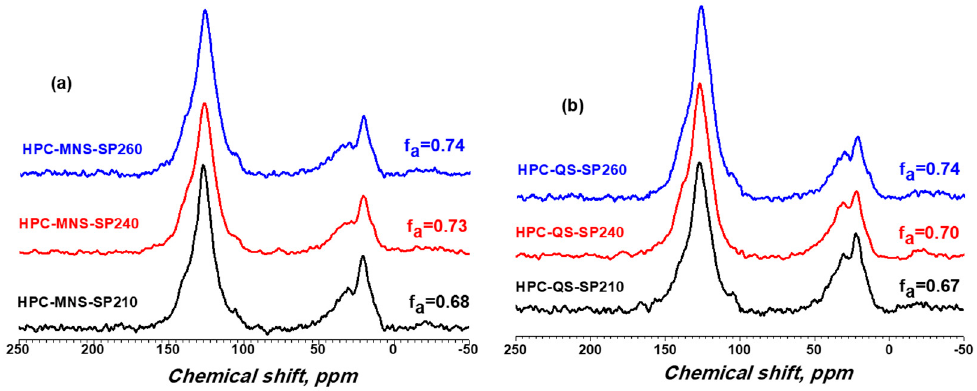
Figure 5. 13 C-NMR spectra of HPC-MNS ( a ) and HPC-QS ( b ) derived pitches.